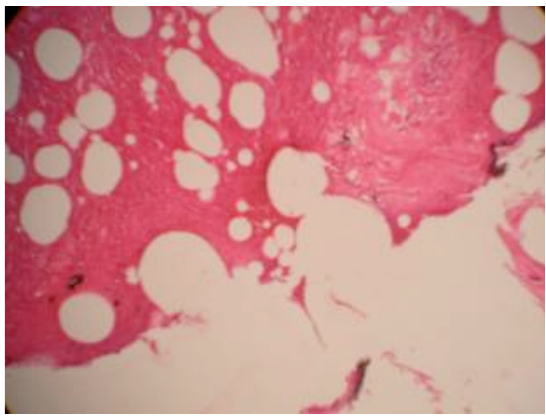
Image 15. Lung of Zebra showing deposition of carbon particles, collapsed alveoli and congestion, Anthracosis, H&E, 100x.